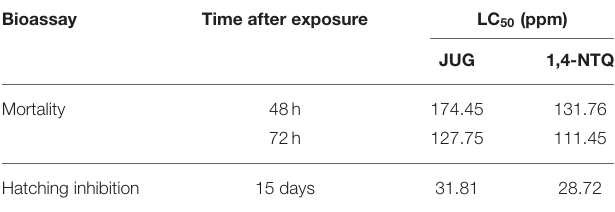
TABLE 2 | Estimated values of lethal concentration (ppm) necessary to result in 50% Meloidogyne luci second-stage juveniles’ mortality and hatching inhibition (LC 50 ), after exposure to juglone (JUG) and 1,4-naphthoquinone